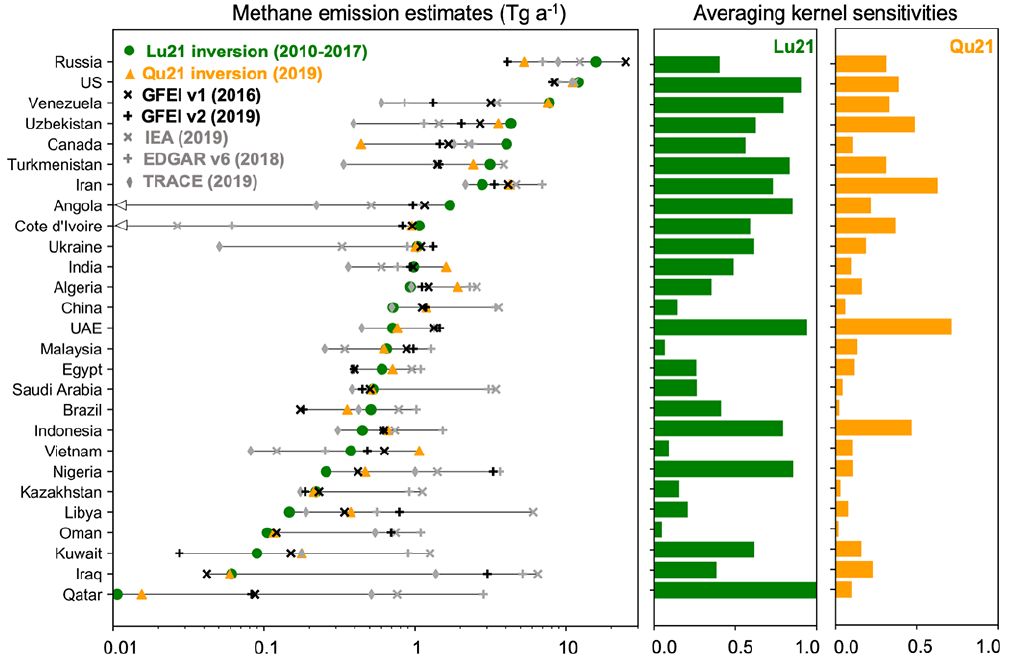
Figure 6. Total oil–gas methane emissions in top-emitting countries. The figure compares bottom-up emissions in the GFEI v1, GFEI v2, EDGAR v5, Climate TRACE, and IEA inventories as well as the inversion results of Lu et al. (2021; Lu21) and Qu et al. (2021; Qu21). Averaging kernel sensitivities for oil–gas emissions in individual countries from the two inversions are also given. The countries shown are those with oil–gas emissions larger than 1Tga − 1 in any of the emission estimates. Horizontal lines extend from the minimum to the maximum emission estimate unless arrow heads designate that emissions in at least one estimate are below 0.01Tga − 1 . US – United States; UAE – United Arab Emirates.